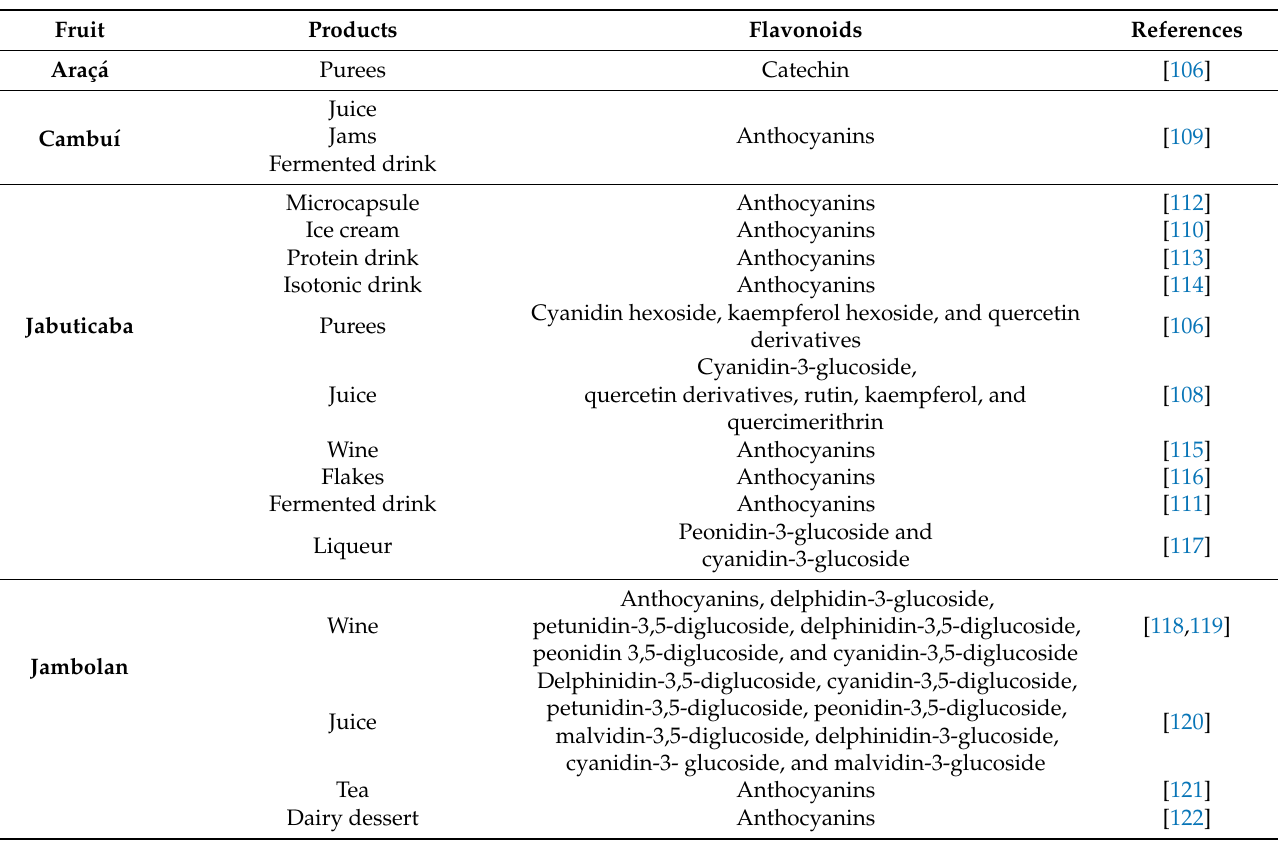
Table 4. Synthesis of selected works with the main flavonoids identified in extracts and their positive health